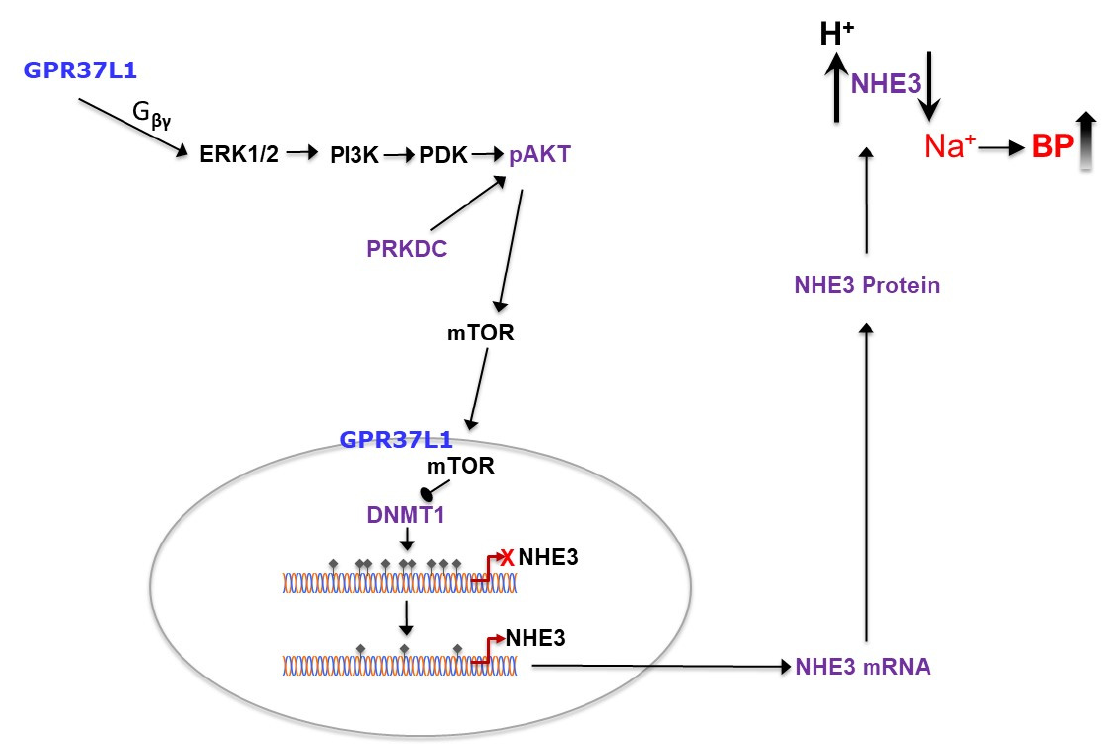
Figure 11. Schematic diagram showing the GPR37L1 signaling pathway in hRPTCs . In hRPTCs, GPR37L1 located on the nuclear membrane signals via the G βγ to phosphorylate ERK/1/2, which in turn phosphorylates PI3K and activates AKT, a main downstream target of mTOR. Activation of mTOR inhibits DNMT1 in the nucleus and increases the transcription of NHE3 through a DNMT1- mediated decrease in the methylation of the NHE3 promoter.